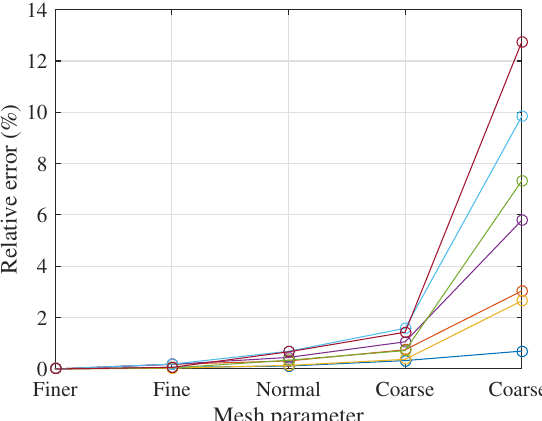
Figure 3. Relative error on natural frequencies versus COMSOL Multiphysics standard mesh parameters for 3D FE model of damaged beam. Each line corresponds to the eigenfrequency in increasing